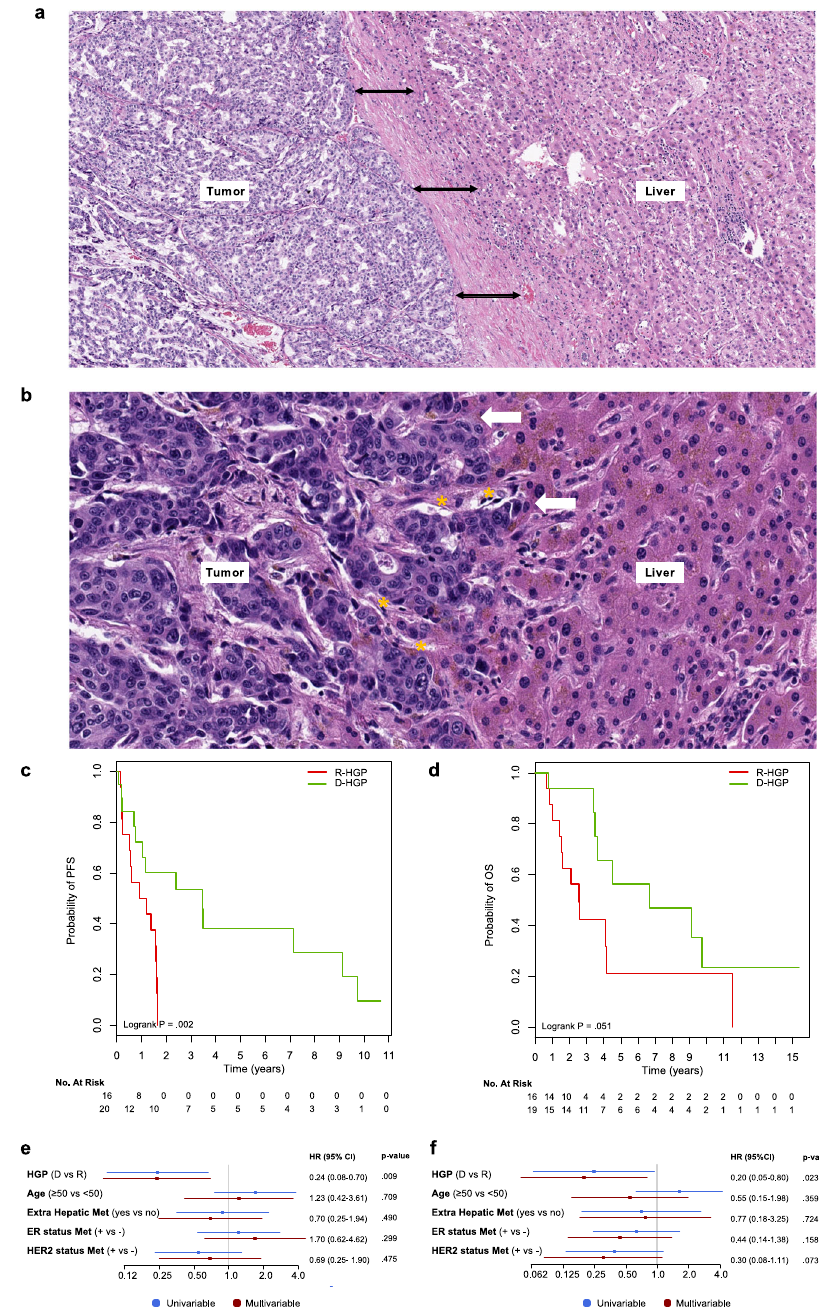
Fig. 1 Histological growth patterns in liver metastases from breast cancer patients. a Breast cancer LM with a desmoplastic growth pattern (H&E staining): black double-headed arrows indicate the desmoplastic rim that separates the tumor tissue from the liver parenchyma. b Breast cancer liver metastasis with a replacement growth pattern (H&E staining): the white arrows indicate some of the regions where cancer cells grow into the liver cell plates and replace the hepatocytes. Cancer cells are in contact with the hepatocytes. The yellow asterisks mark two co- opted sinusoidal blood vessels. c Kaplan – Meier curves displaying the PFS probability according to the HGP group. d Kaplan – Meier curves displaying the OS probability according to the HGP group. e Univariate and multivariate Cox regression analyses for PFS. f Univariate and multivariate Cox regression analyses for OS. CI con fi dence interval, HGP histological growth pattern (D desmoplastic, R replacement), H&E hematoxylin and eosin, LM liver metastasi(e)s, PFS progression-free survival, OS overall In 33% of the patients (10/30), the ER status differed between the or more) desmoplastic, further referred to as “ any D-HGP ” and primary tumor and LM. In 8 patients, ER expression was lost in the present in the remaining 20 patients (56%). There was no association between these HGP categories and LM, while in 2 patients the LM gained ER expression. Signi fi cantly estrogen receptor (ER) or HER2 status of the primary breast more patients in the “ pure R-HGP ” group had a primary tumor carcinoma or of the LM (Table 1). LM subtypes were as follows: 7 associated with lymph node metastases (79 versus 44% in the “ any D-HGP ” group; p = 0.02). ER − /HER2 − (19%), 12 HER2 + (33%), and 17 ER + /HER2 − (47%).